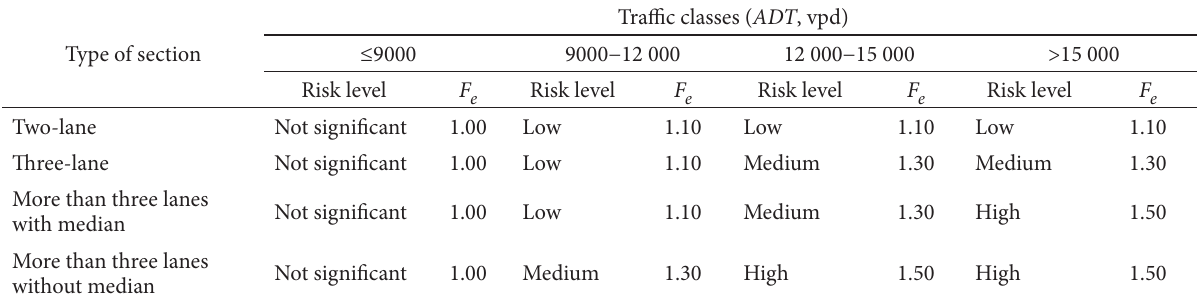
More than three lanes with